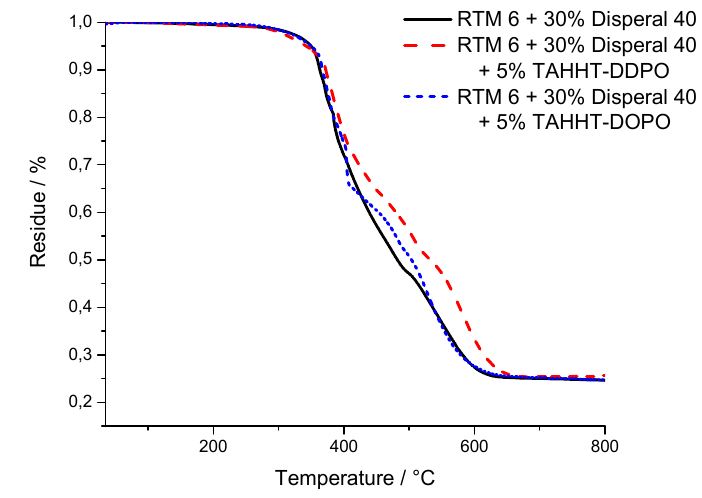
Figure 14. TG curves of Actilox-containing samples measured under air.